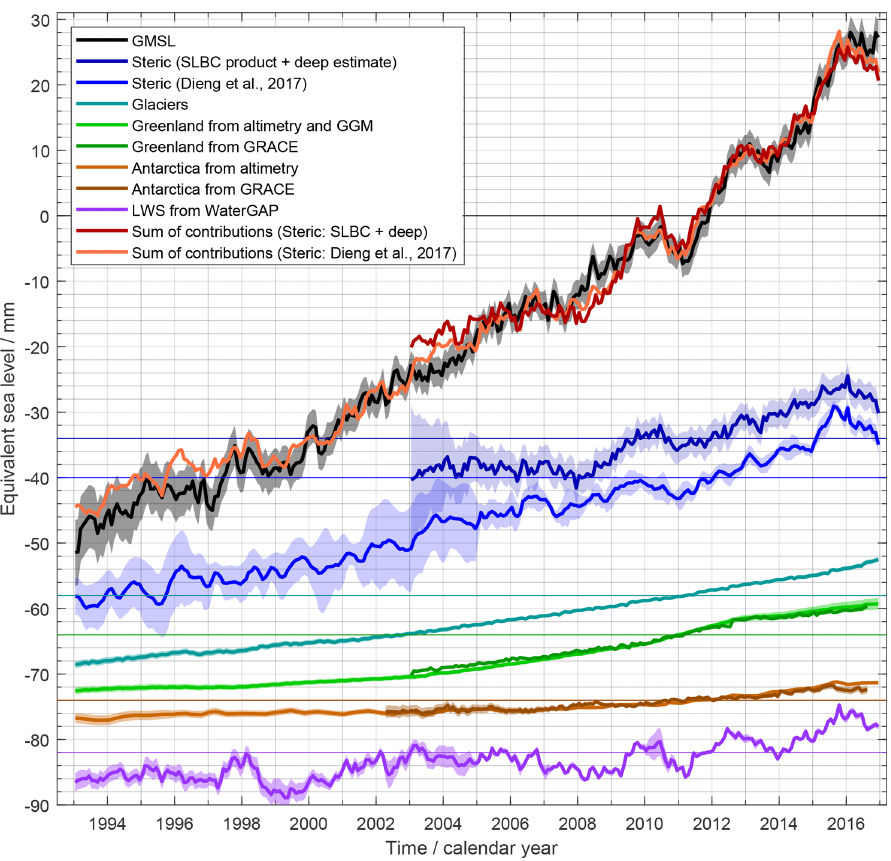
Figure 12. Time series of SLB elements involving the individual contributions to ocean-mass change. See legend for attribution of graphs. The sum-of-components graphs use altimetry-based ice sheet assessments. The GRACE-based time series and the Antarctic altimetry time series were interpolated to monthly sampling. Seasonal variations are subtracted. Each graph shows anomalies with respect to a mean value over 2006–2015. Graphs are shifted arbitrarily along the ordinate axis. Standard uncertainties are shown by transparent bands (except for the sum-of-contribution